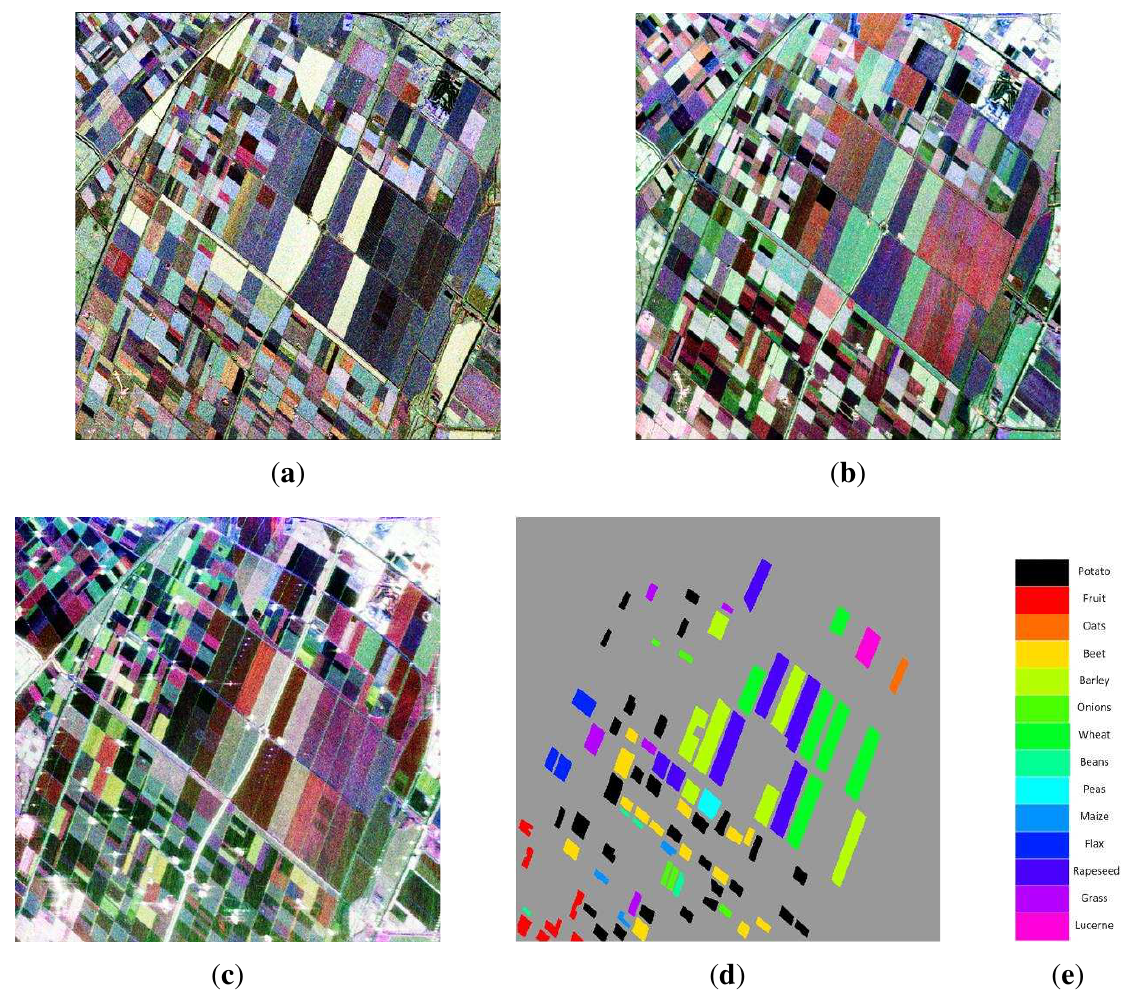
Figure 2. The pseudo-color images and ground-truth: ( a – c ) Pauli pseudo-color images of C, L and P bands; ( d ) the ground-truth [21]; ( e ) the types of crops and the corresponding